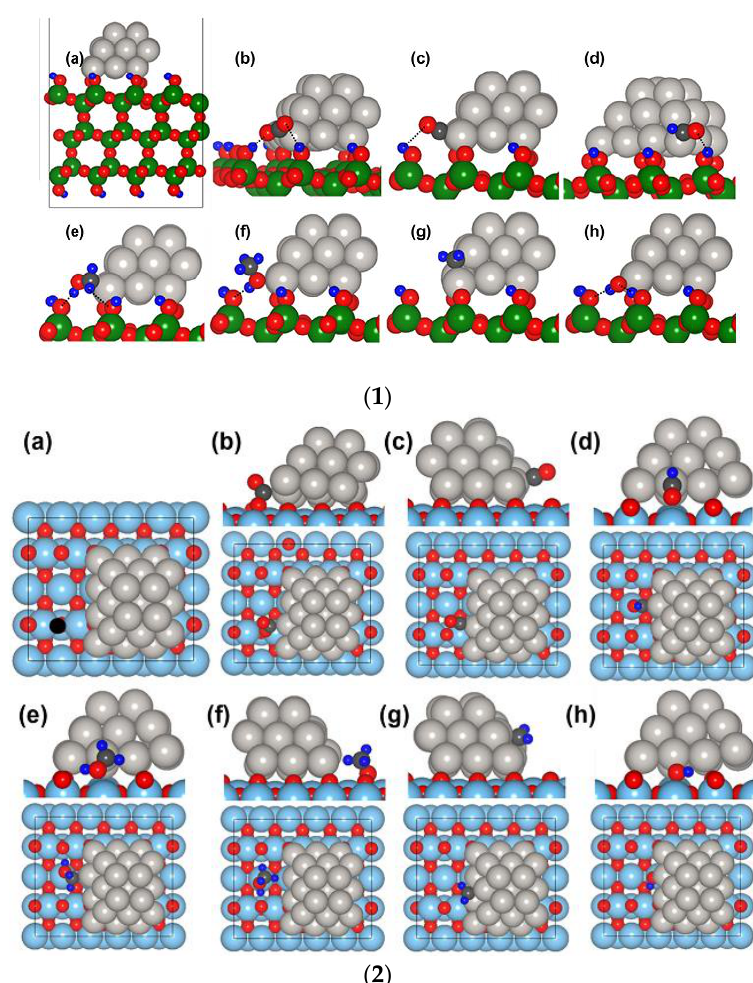
Figure 5. DFT optimized geometries. ( 1 ) ( a ) Pt 25 /hydroxylated SiO 2 (111), and ( b ) *CO 2 species, ( c ) *CO species, ( d ) *HCO species, ( e ) *H 2 COH species, ( f ) *CH 3 OH species, ( g ) *CH 2 species, and ( h ) *OH species adsorbed on Pt/SiO 2 (111). The dashed lines show hydrogen bonds. ( 2 ) ( a ) Pt 25 /TiO 2 (110) with oxygen vacancy, and side ( top ) and top ( bottom ) views of ( b ) *CO 2 species, ( c ) *CO species, ( d ) *HCO species, ( e ) *H 2 COH species, ( f ) *CH 3 OH species, ( g ) *CH 2 species, and ( h ) *OH species adsorbed on Pt/TiO 2 (110). The black circle in (a) depicts the position of oxygen vacancy on TiO 2 (110). Note: Si: green, Ti: light blue, Pt: light gray, C: dark gray, O: red, and H: blue, reprinted with permission from [21]. Copyright Elsevier, 2016.